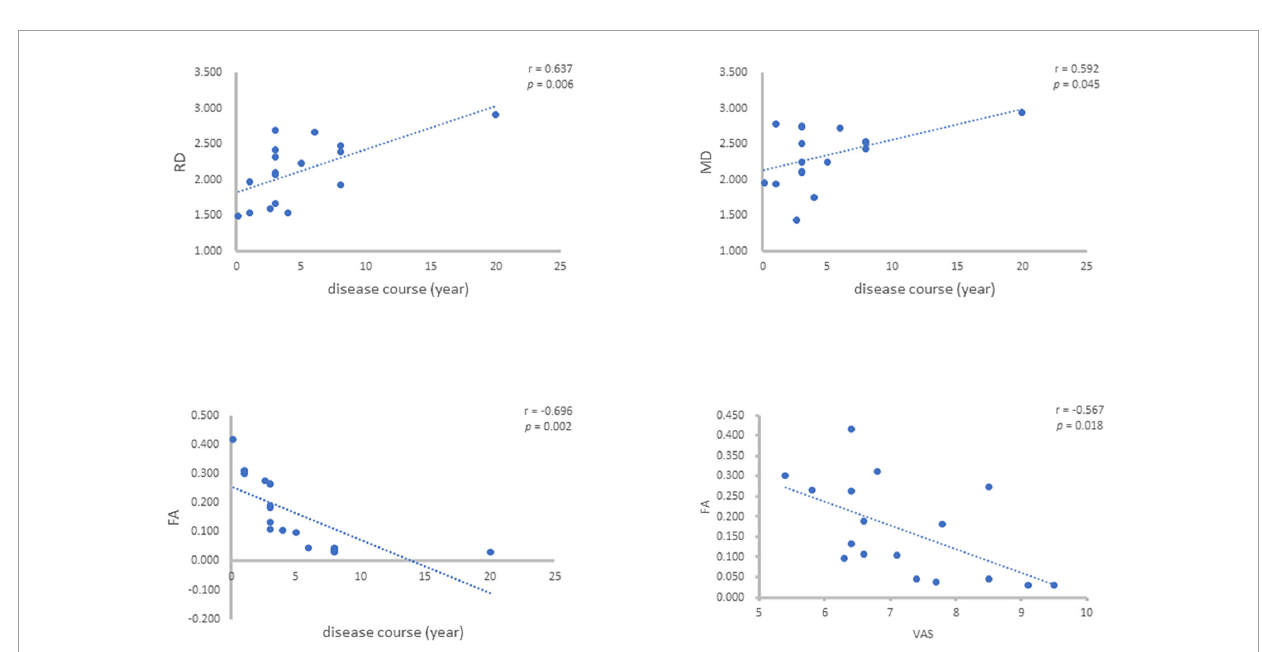
FIGURE3 Correlation between FA, MD, AD, and RD of PTN patients and their disease course and VAS.